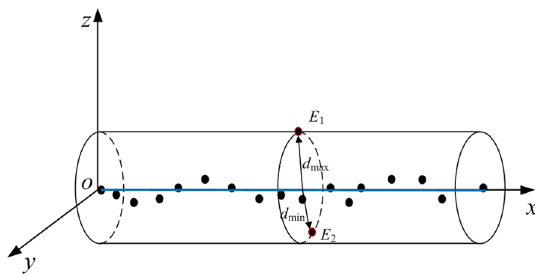
Figure 11. Schematic of the space axis fitting.